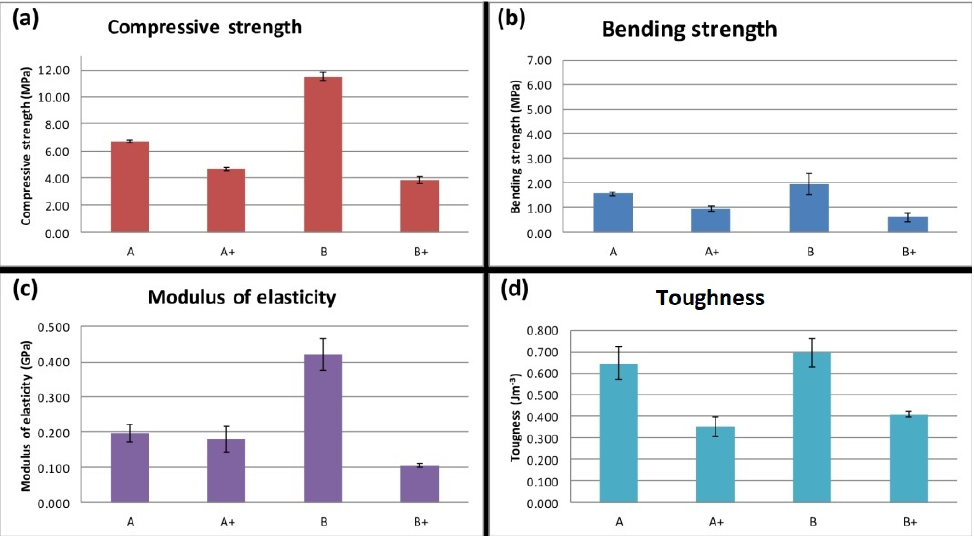
Figure 6. ( a ) Compressive strength, ( b ) bending strength, ( c ) modulus of elasticity, and ( d ) toughness of the designed mortars in 28 days.